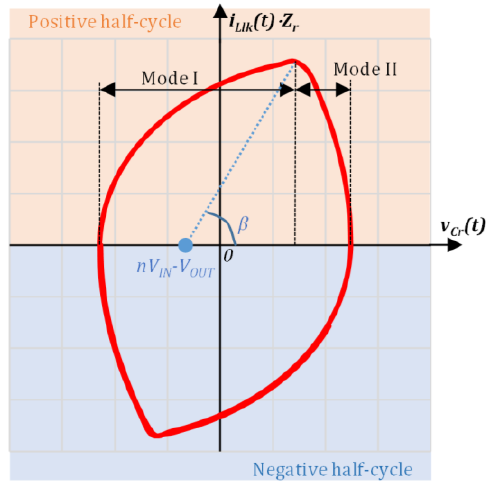
Figure 7. State-plane trajectory of the resonant tank with the proposed short-pulse PWM for ∆𝑉 𝐶𝑟 > 2𝑛𝑉 𝐼𝑁 .